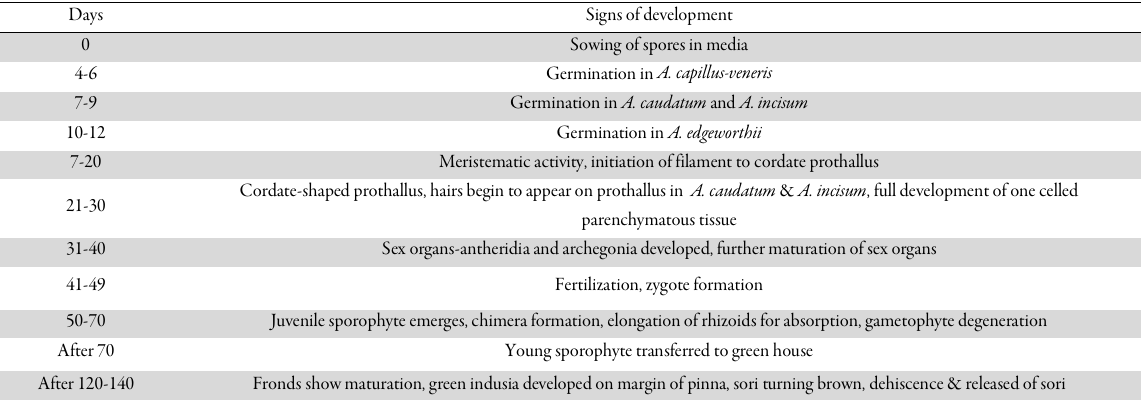
Table 2. Stages of gametophyte development in Adiantum species from the day of sowing to of spore dehiscence stage in sporophytes